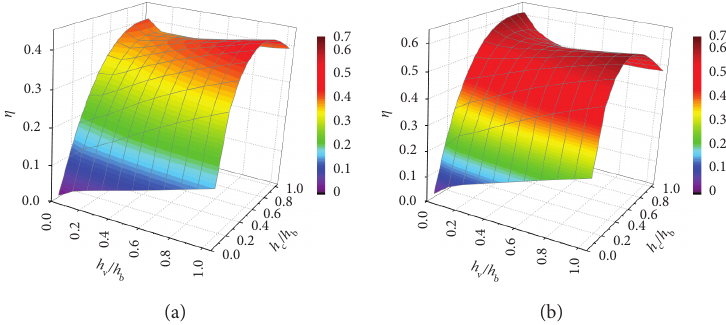
Figure 8: The parameter effects on the sum of the first three modal loss factors. (a) Structure 1. (b) Structure 2.